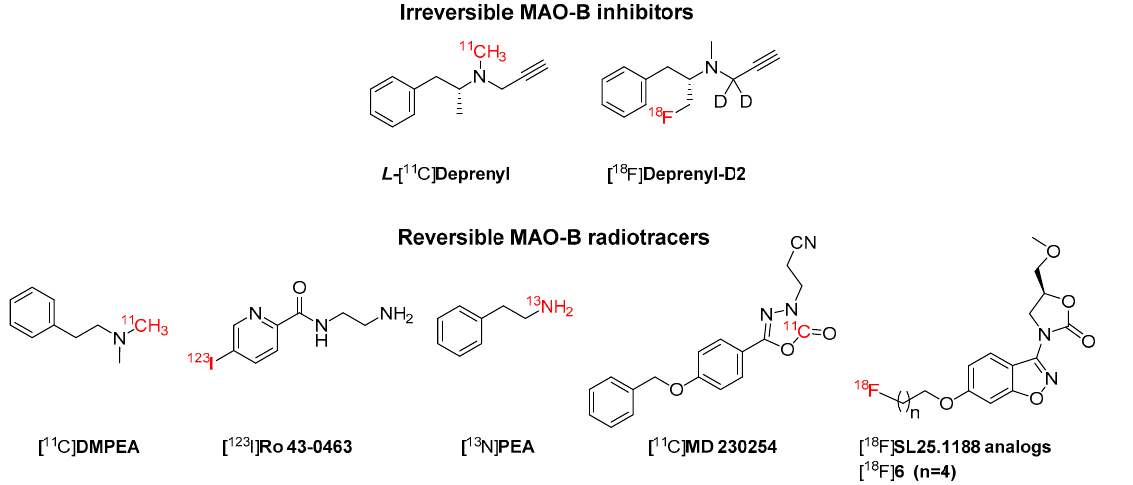
Figure 1. Representative irreversible and reversible monoamine oxidase B (MAO-B) imaging agents.